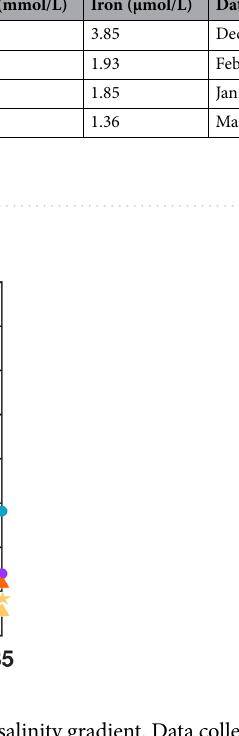
Figure 1. Change in iron concentration (µM) over an artificial salinity gradient. Data collected using a Cary 300 Eclipse spectrophotometer. Data was converted from absorbance to concentration using a linear FeCl 3 calibration curve. Limit of quantification (LOQ) = 0.28 µmol/L, Limit of detection (LOD) = 0.08 µmol/L. Measurements below LOQ have a small star above